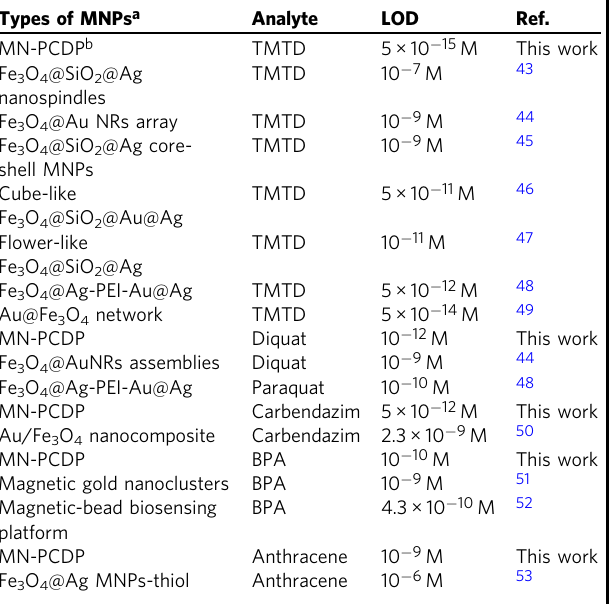
Table 1 Detectability of the MNPs for organic pollutants reported in the